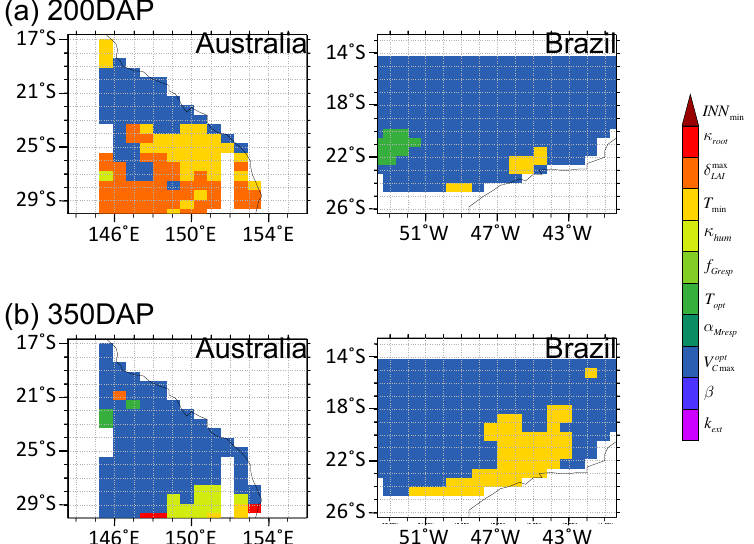
Figure 10. Spatial distribution of the most influential parameters for the simulation of harvestable biomass for two milestones during the growing season, 200 days after planting (DAP) and